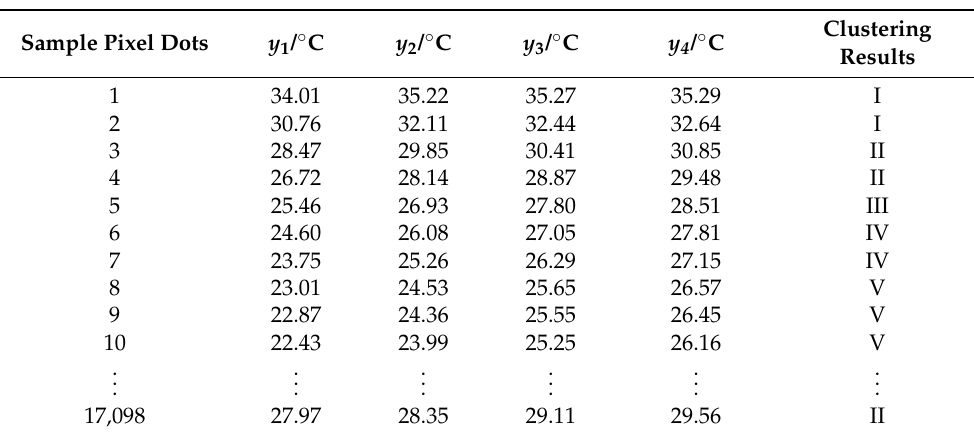
Table 4. Clustering results of each pixel